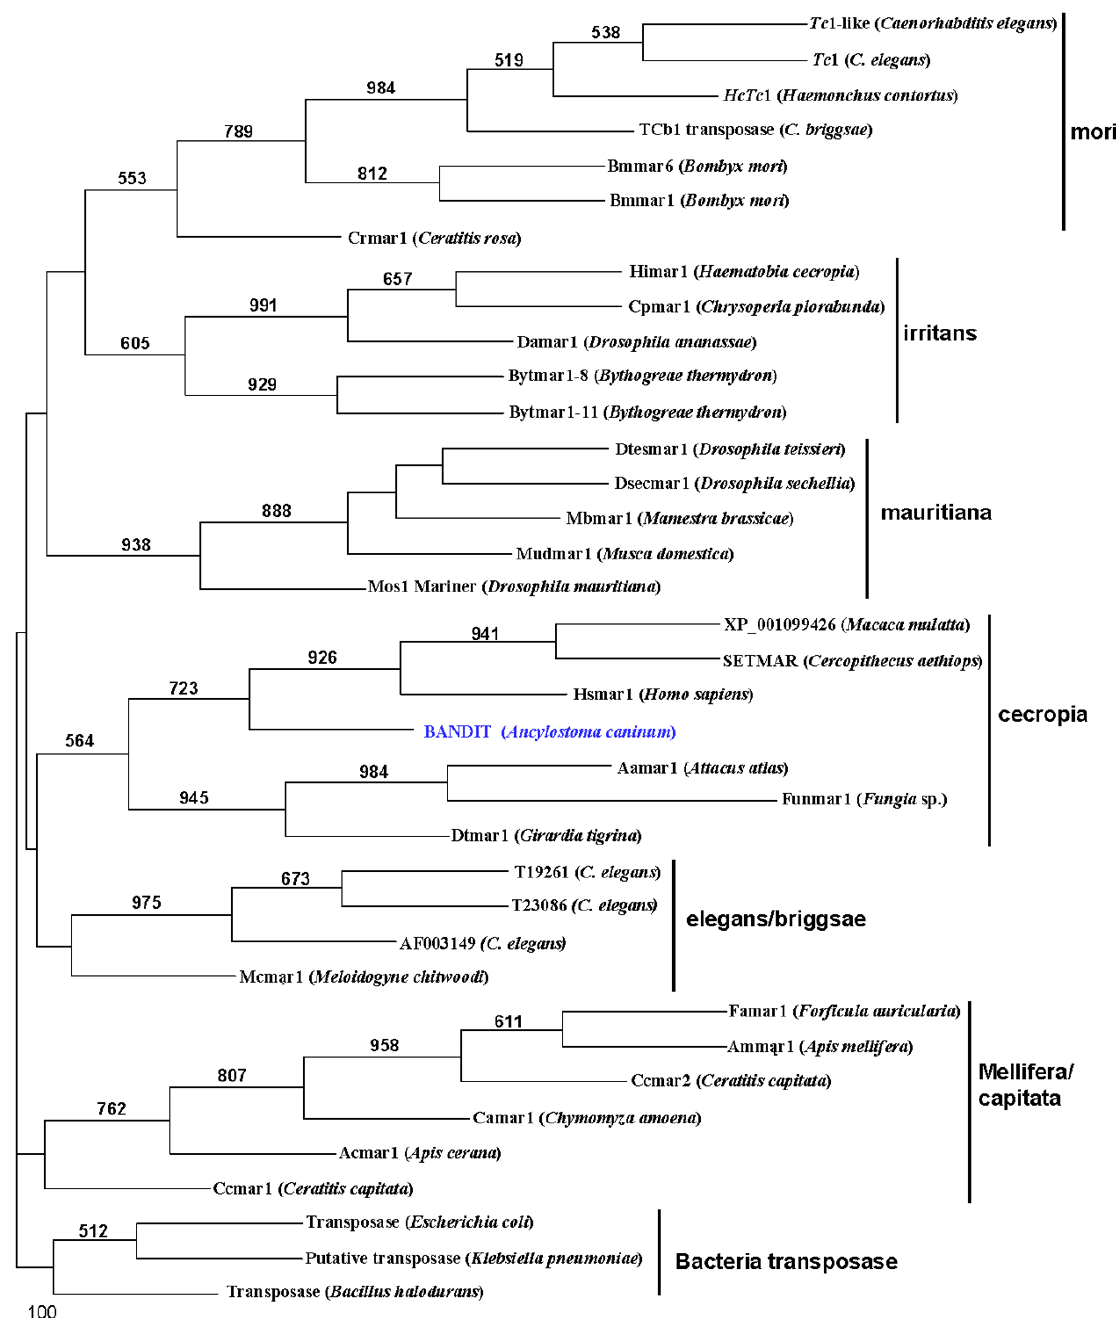
Figure 4. Phylogram constructed using the neighbor-joining method to compare the relationships among transposases of the bandit transposon and of representative mariner-like elements belonging to the Tc1/mariner superfamily of transposons from a range of host genomes. Representatives of six clades of mariner-like elements including the mori, irritans, mauritiana, and cecropia were included in the analysis. The elements used in the tree includes Tc1-like (AAD12818) and Tc1 (P03934), T19261, T23086 and AF003149 from C. elegans , HcTc1 (AAD34306) from Haemonchus contortus , TCb1 (CAA30681) from C. briggsae , Bmmar1 (U47917) and BmMar6 (AAN06610) from Bombyx mori , Crmar1 (AAK61417) from Ceratitis rosa , Himar1 (ABB59013) mutagenesis vector pFNLTP16H3, Cpmar1 (AAC46945) from Chrysoperla plorabunda , Damar1 (DAU11648) from Drosophila ananassae , Bytmar1-8 (CAD45868) and Bytmar1-11 (CAD45369) from Bythogreae thermydron , Dtesmar1 (AAC28261) from D. teissieri , Dsecmar1 (AAC16609) from D. sechellia , Mbmar1 (AAL69970) from Mamesta brassicae , Mudmar1 (AK54758) from Musca domestica , Mos1 (pdb2F7T) from D. mauritiana , XP_001099426 from Macaca mulatta , SETMAR (ABC72092) from Cercopithecus aethiops , Hsmar1 (AAC52010) from Homo sapiens , Aamar1 (BAA21826) from Attacus atlas , Funmar1 (BAB32436) from Fungia sp., Dtmar1 (CAA50801) from Girardia tigrina , Mcmar1 (CAD26968) from Meloidogyne chitwoodi , Famar1 (AAO12863) from Forficula auricularia , Ammar1 (AAO12861) from Apis mellifera , Ccmar2 (AAO12864) from Ceratitis capitata , Camar1 (AAO12862) from Chymomyza amoena , Acmar1 (BAB86288) from Apis cerana , Ccmar1 (AAB17945) from Ceratitis capitata . The outgroup included transposases from gram positive and negative bacteria including Bacillus halodurans (BAA75315), Escherichia coli (AAB28848) and Klebsiella pneumoniae (CAB82575). Bootstrap values, where 500 or greater from a maximum of 1,000 replicates, are presented at the nodes.